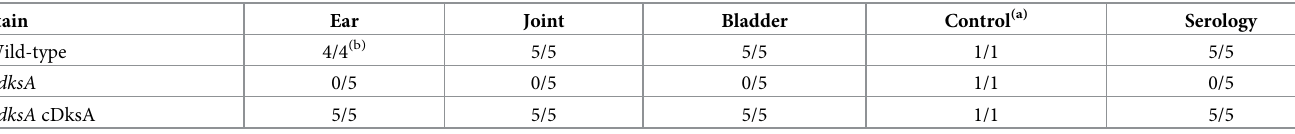
Table 1. Evaluation of the potential for DksA-deficient B . burgdorferi to cause infection. Stain